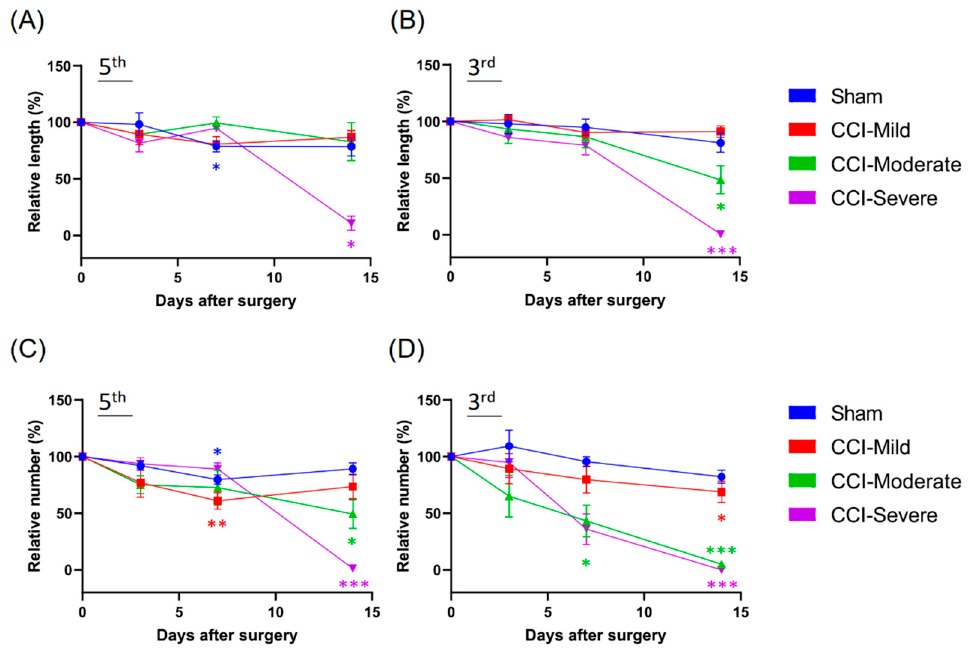
Figure 4. Changes in the sub-epidermal nerve plexus and nerve terminals in the third and fifth toe tips of mice in the CCI subgroups and the sham group. ( A , B ) Changes in the relative length of the nerve plexus. At 14 d after CCI surgery, the nerve plexus length was significantly reduced in both the third and the fifth toe tips of mice in the CCI-severe group. Mice in the CCI-moderate group only showed significant decreases in the length of the nerve plexus length in the third toe tip. ( C , D ) Changes in the relative number of nerve terminals. In the CCI-mild group, nerve terminals were significantly reduced in the fifth toe tip at 7 d after CCI but had recovered to baseline levels at 14 d. Both the CCI-moderate and the CCI-severe groups had significantly fewer terminals in the fifth toe tip at 14 d post CCI surgery. All CCI subgroups had significantly fewer terminals in the third toe tip at 14 d. * p < 0.05, ** p < 0.01 and *** p < 0.001, compared to baseline.